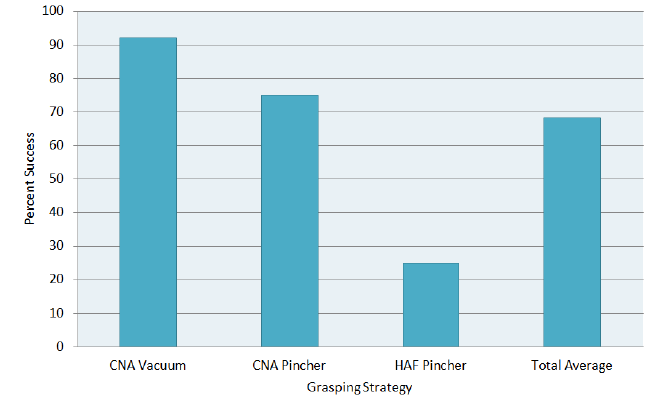
Figure 14. Percent success per grasping strategy with isolated objects; each success rate has been determined for the corresponding subset of objects. The total average is weighted with the percentage of items per strategy, including the 6 blacklisted not_possible items.